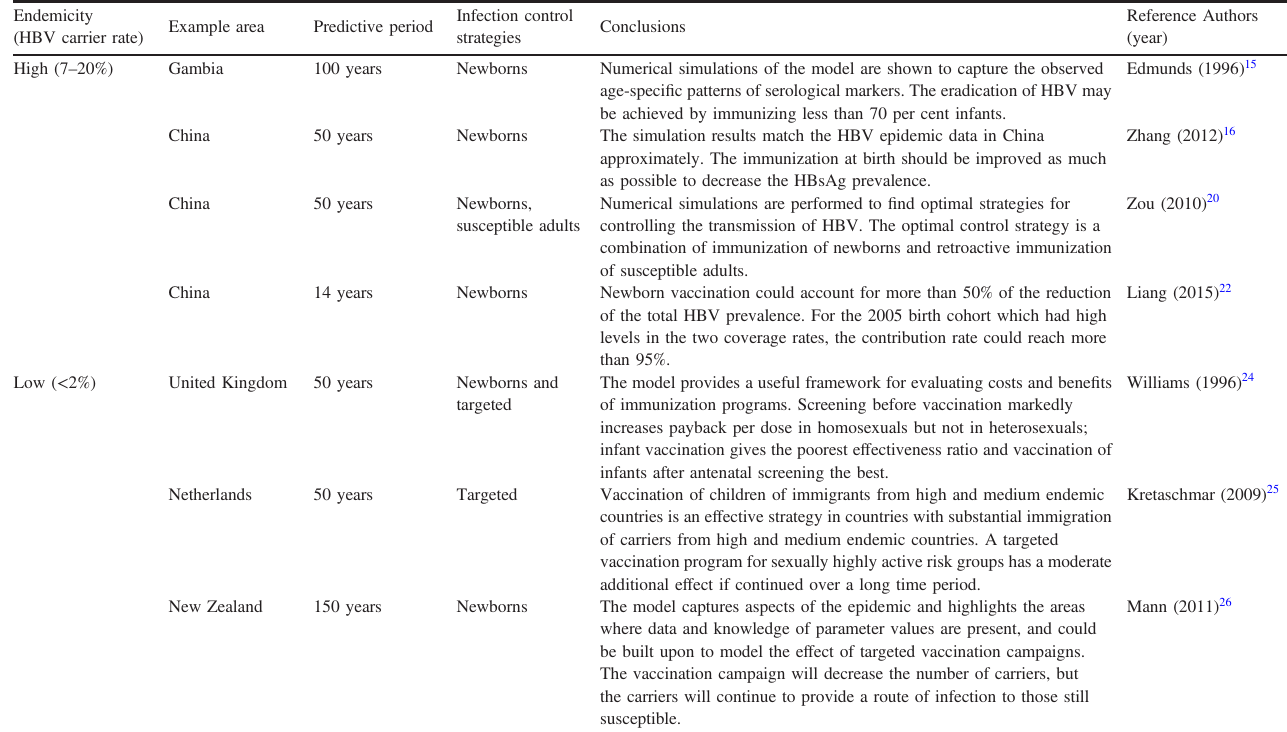
Infection control